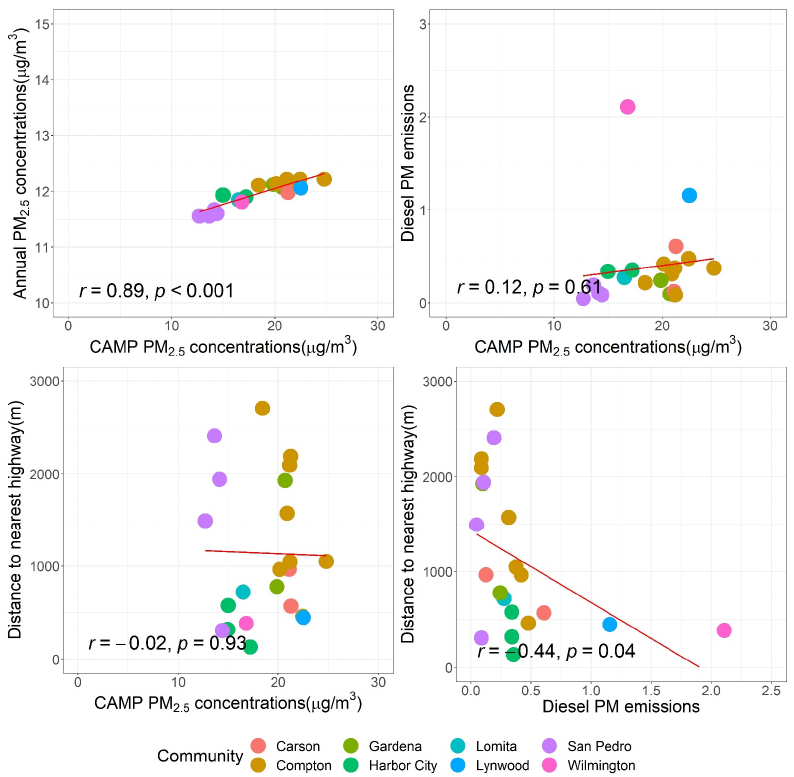
Figure 6. The comparisons of CAMP PM 2.5 concentrations, annual PM 2.5 concentrations, distance to nearest highway, and diesel PM emissions by community.